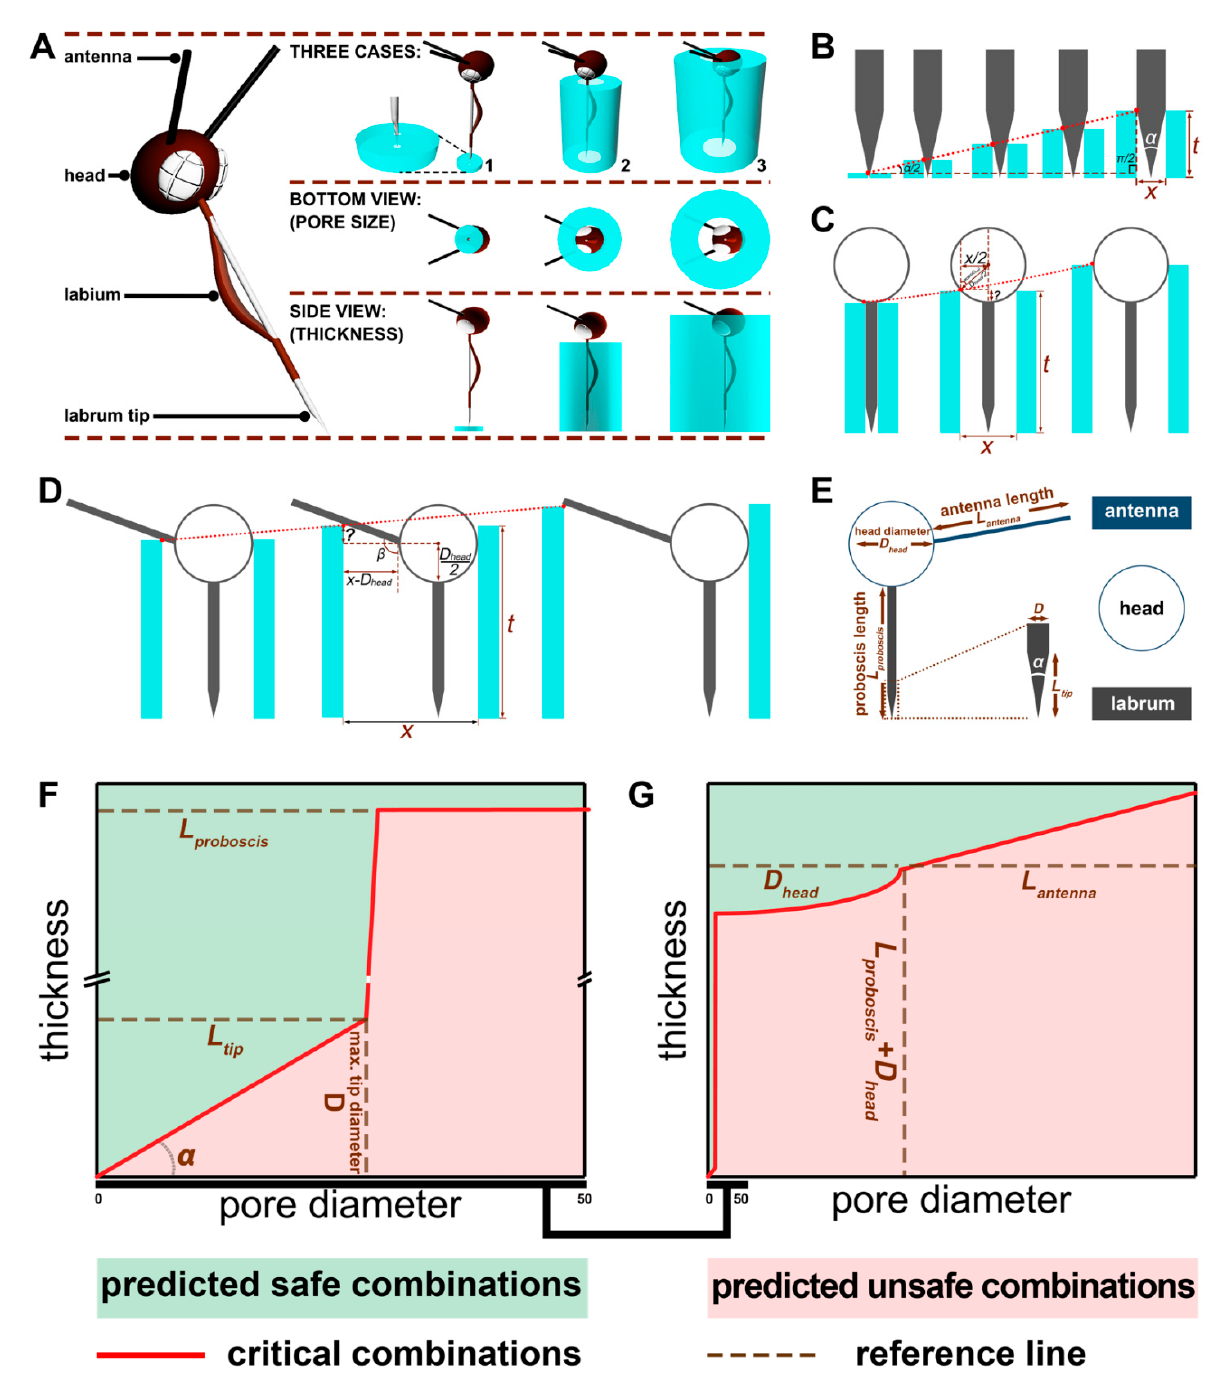
Figure 2. Bite-resistance model development. ( A – D ) Ice green vertical bars are the textile barrier, and the red dotted line the critical combination of pore diameter and thickness of the textile barrier. ( A ) Three cases that prevent mosquito biting based on mosquito anatomy. ( B ) Case 1—the pore diameter is smaller than the labrum diameter. ( C ) Case 2—the pore diameter is larger than the labrum diameter but smaller than the head diameter. ( D ) Case 3—the pore diameter is larger than head diameter but smaller than the sum of the head diameter and antenna length. ( E ) Abbreviations for length and diameter of the mosquito anatomy. ( F ) Zoomed-in view of the Case 1 model. ( G ) Case 1, Case 2, and Case 3 model predictions. Brown dotted lines in ( F , G ) are the critical parameters measured from the anatomy of the Ae. aegypti female in Figure S1 that define the three cases’ combinations of porosities and thicknesses of the textile.